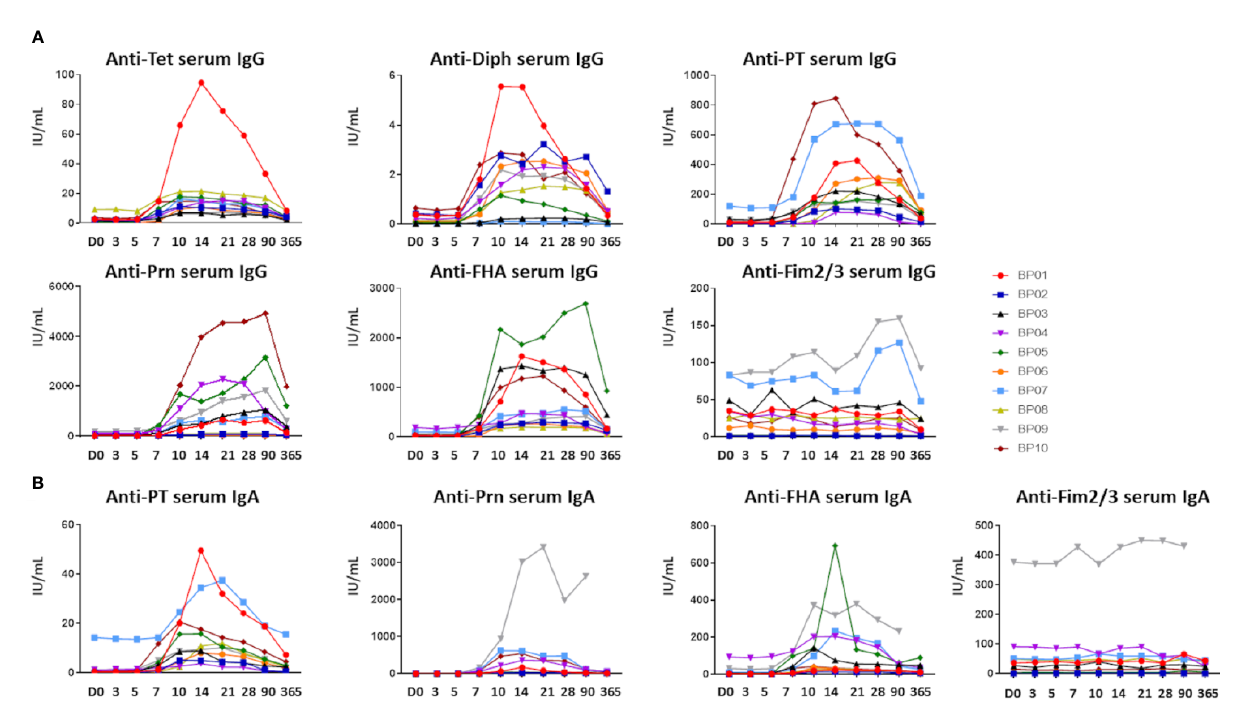
FIGURE 2 | Ag-speci fi c serum Ig levels prior to and post-aP booster vaccination. (A) Ag-speci fi c serum IgG levels (IU/mL) directed against the 5 vaccine components (Diphtheria toxoid (Diph), tetanus toxoid (Tet), PT, FHA and Prn). Fim2/3 was not present in the vaccine and considered a negative control in (A, B) . (B) Ag-speci fi c serum IgA levels (IU/mL) directed against the Bp vaccine components (PT, FHA, Prn). For Diph and Tet no quantitative read-out was available. D, Days after